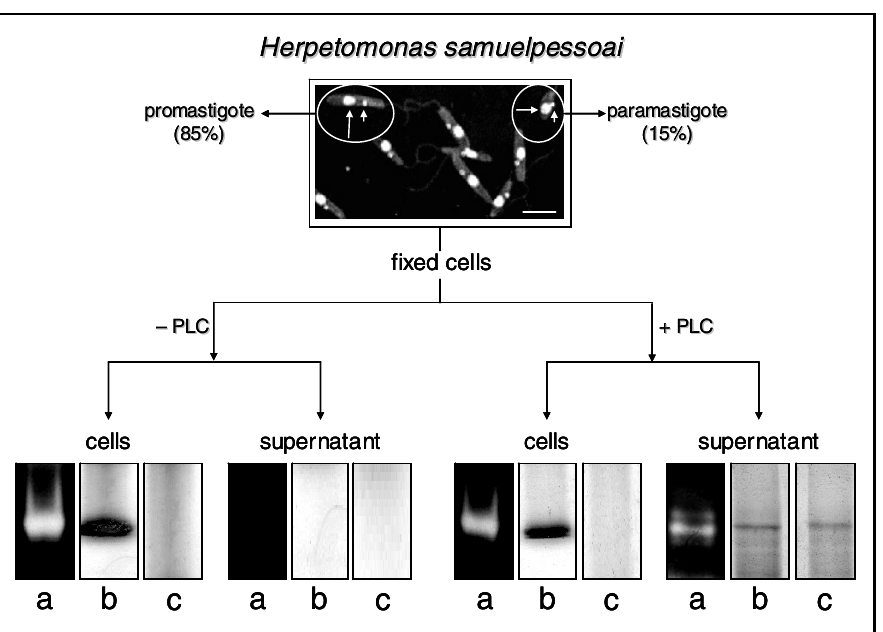
Fig. 3 – Effect of exogenous phospholipase C (PLC) on the cell surface of Herpetomonas samuelpessoai cells. The fluorescence microscopy shows the different evolutive stages incubated with DAPI to evidence the nucleus (arrows) and kinetoplast (arrowheads). Parasites were fixed with paraformaldehyde and then incubated in the absence ( – ) or in the presence ( + ) of 0.1 U/ µ L of PLC in 100 µ L of PBS supplemented with 20% glycerol for 3 h at 37 ◦ C. The mixtures were then harvested by centrifugation and the supernatants from the reaction mixtures were collected and filtered in a 0.22 µ m membrane. The cells were lysed by Triton X-114 to obtain the membrane-rich fraction. The membrane extracts and the supernatants were then analyzed by gelatin-SDS-PAGE ( a ), Western blotting probed with anti-gp63 antibody (Chang and Chang 1986) at 1:1000 ( b ) or anti-CRD antiserum at 1:400 ( c ). For experimental details see Santos et al. 2002a and Elias et al. 2006. Note that the PLC treatment significantly reduced the surface metalloprotease activity due to the cleavage of the GPI anchor, releasing three distinct metalloproteases to the extracellular medium (reaction mixture) that were recognized by both